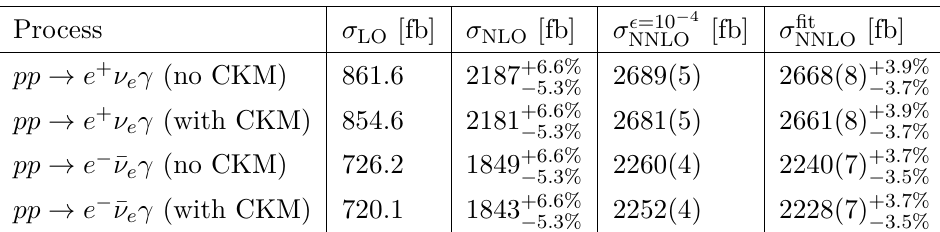
Table 4 . Cross-section results with the cuts of table 3. The theoretical error is estimated by a 7-point scale variation. Parentheses indicate the residual error resulting from numerical integration of the NNLO result (this error is beyond the indicated number of digits at